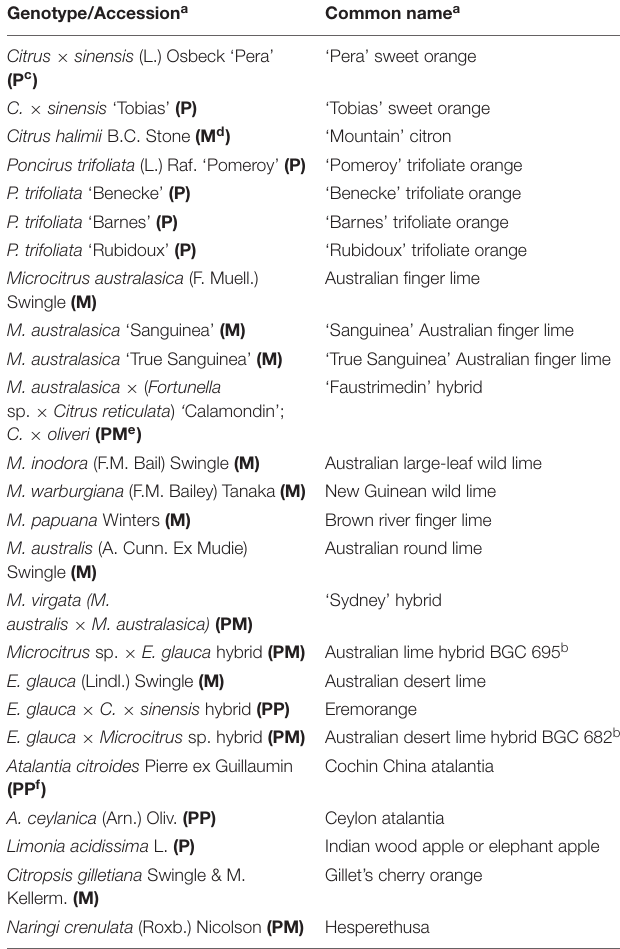
TABLE 1 | Citrinae genotypes/accessions tested for resistance to ‘ Candidatus Liberibacter